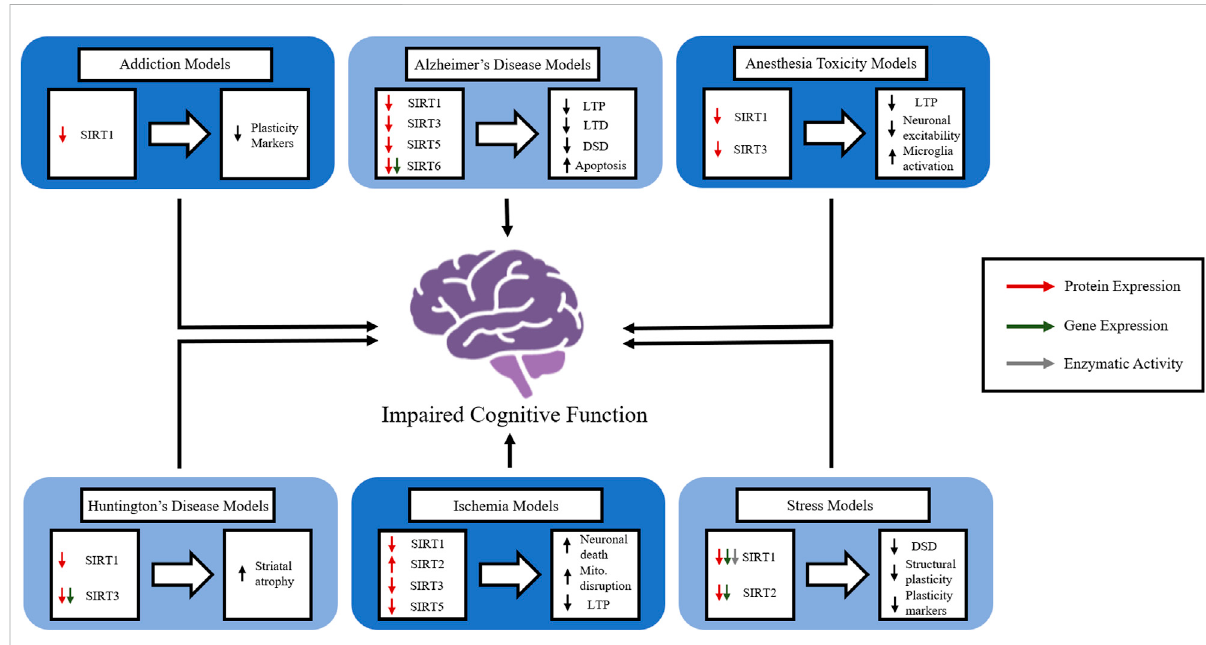
FIGURE 2 The role of members of the sirtuin family in in vivo models of various neurological disorders. The fi gure represents how individual sirtuins are affected in a variety of neurological disorders and how the disruption of sirtuin function causes disruptions in normal brain function. Long-term potentiation (LTP), long-term depression (LTD), dendritic spinal density (DSD), mitochondria